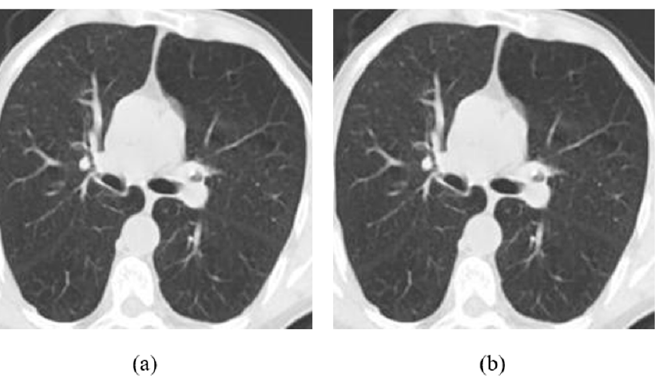
Figure 9. ( a ) Clean Image, ( b ) Attacked image (L ‐ Bit = 100, Embedding strength = 50) . Moreover, MobileNetV2 is the weakest model, as it loses accuracy easier than the other two models with no need for a perceptible distortion. This may be due to the fact that MobileNetV2 has fewer parameters compared to the other models. In CT-scans case, which was the weakest one, all models lost an important percentage of accuracy with the lowest values, however, the DenseNets lost their accuracy at a slower pace than MobileNetV2. Furthermore, in MRI and X-ray cases DenseNet201 and DenseNet169 need a combination of high values of embedding strength and L-Bit length to significantly reduce their accuracy. On the other hand, the accuracy of MobileNetV2 is significantly decreased when